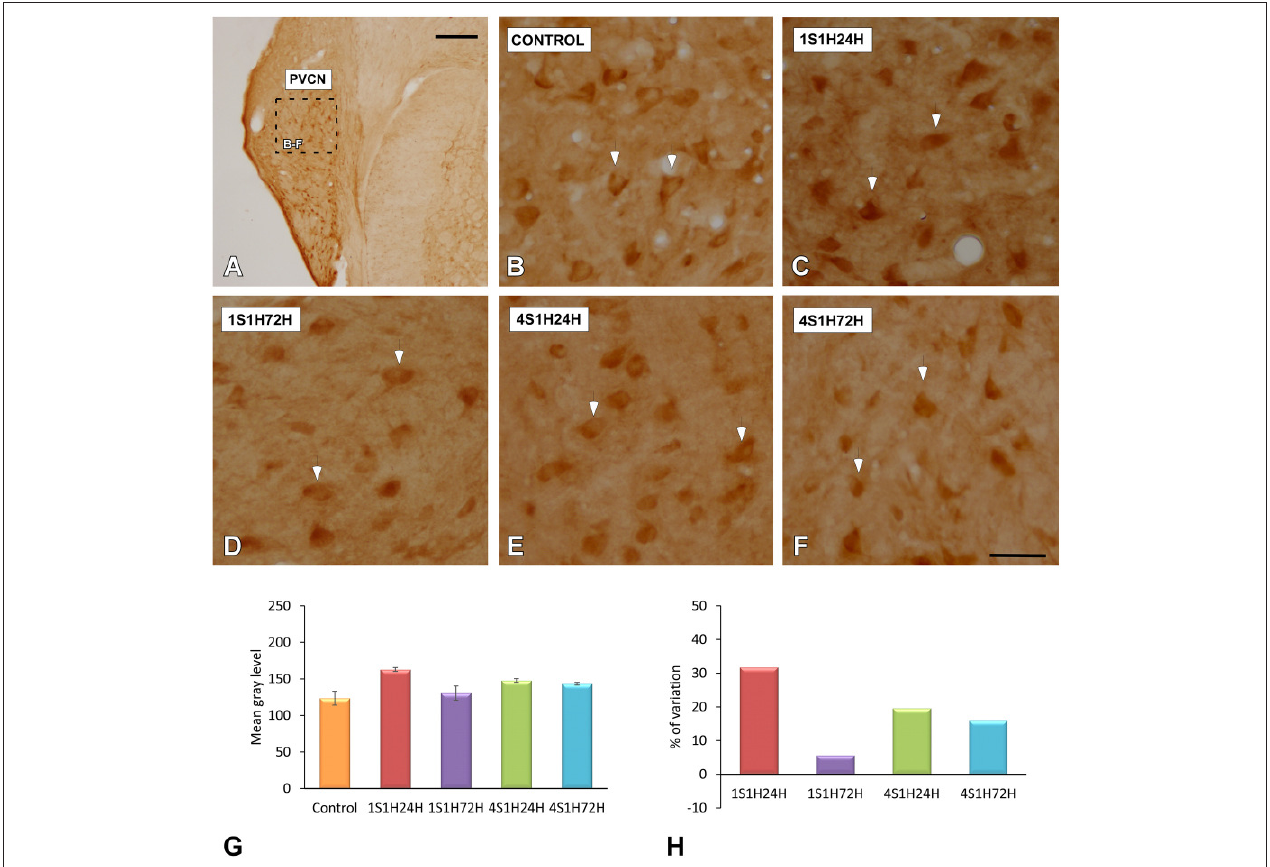
FIGURE 11 | Digitized images illustrating nNOS immunostaining in the PVCN in control and experimental Wistar rats. Similar to that in the AVCN, nNOS immunostaining in the 1S1H24H condition was increased (arrows in C ) when compared to the control condition. Although nNOS levels decreased in 1S1H72H (arrows in D ) rats, they increased slightly in 4S1H24H (arrows in E ) and 4S1H72H (arrows in F ) animals when compared to the control condition (arrows in B ). Bar graphs indicate the mean gray level of nNOS immunostaining (G) and the percentage of variation (H) in the experimental conditions with respect to control. The square box in A indicates the approximate location of the high-magnification images shown in (B,C,E,F) . Scale bars represent 250 µ m in (A) , and 50 µ m in (F) .